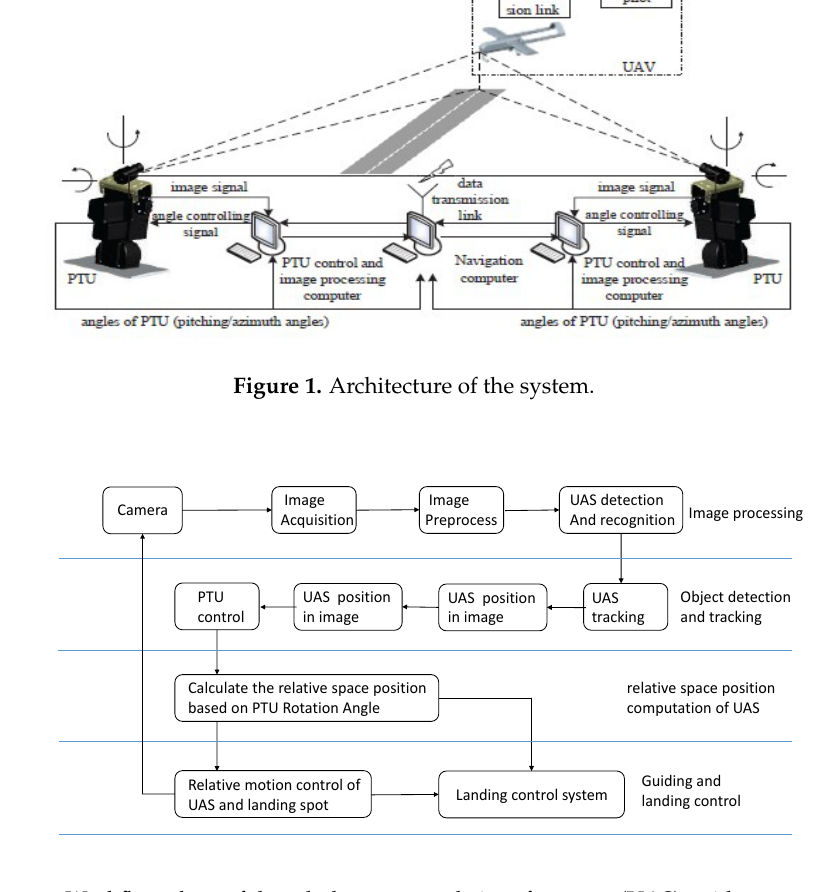
Figure 2. Workflow chart of the whole unmanned aircraft system (UAS) guidance